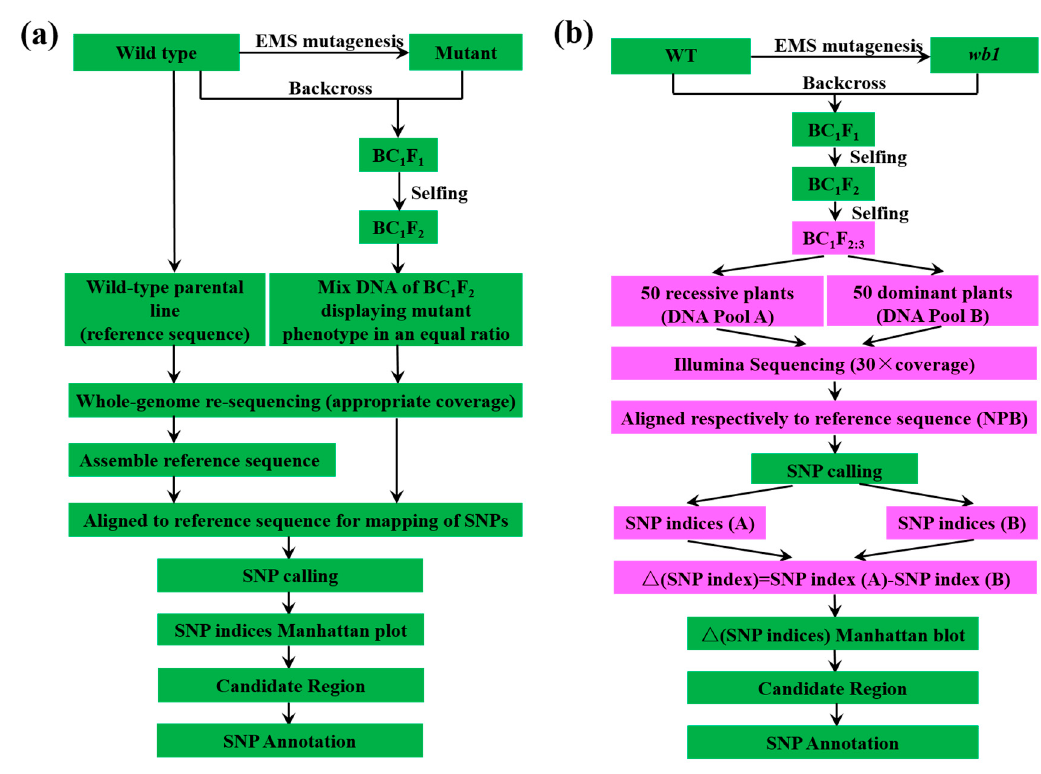
Figure 1. The steps of MutMap method applied to rice. ( a ) Common scheme of MutMap method applied to rice following the protocol described as previously reported [33]; ( b ) The scheme of gene mapping used in this study. The BC 1 F 2:3 progeny formed mapping population. DNA of 50 recessive and 50 dominant plants from mapping population are mixed separately in an equal ratio to form the DNA Pool (A) and Pool (B) followed by the construction of DNA library and Illumina sequencing with 30×coverage, and then the treated sequencing data were aligned with the reference sequence followed by single nucleotide polymorphisms (SNP) calling. The reference sequence is the publicly available Nipponbare rice genome sequence [37]. For each identified SNP, SNP index (A) was obtained from Pool (A) and SNP index (B) corresponds with Pool (B). SNP index (A) minus SNP index (B) is ∆ (SNP index) which is used for Manhattan plot, and we can obtain candidate region followed by SNP annotation. The pink color represents the different steps compared to the common scheme of MutMap. EMS: Ethane methyl sulfonate.